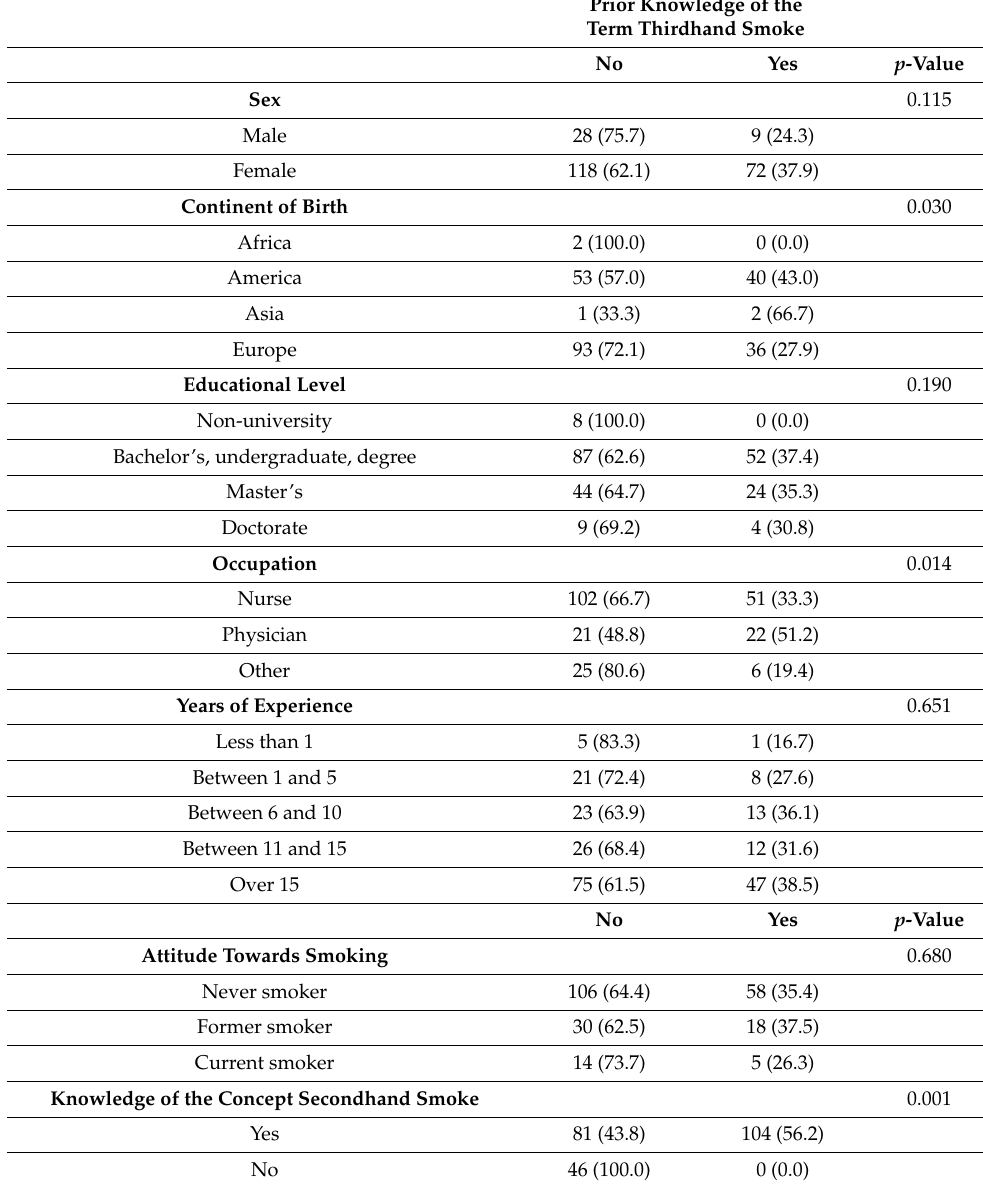
Table 3. Association between prior knowledge of the concept thirdhand smoke and